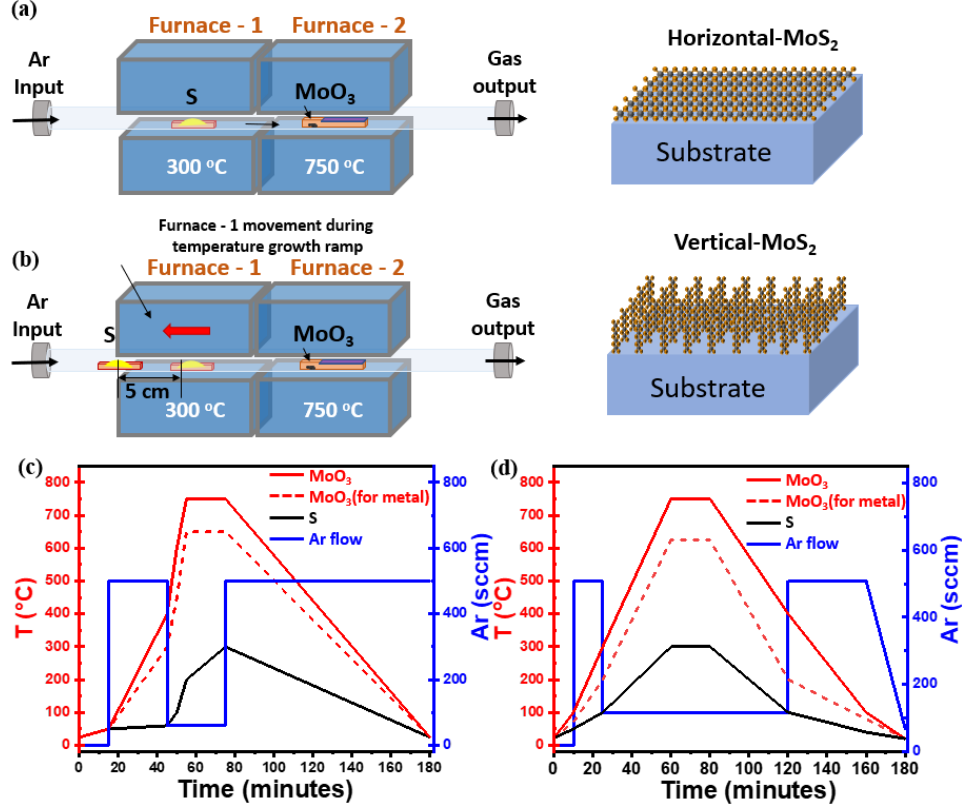
Figure 1. ( a ) Schematic diagram of the horizontal two-zone CVD furnace for the synthesis of flat-MoS 2 . ( b ) Modified CVD setup used to synthesize vertical-MoS 2 nanosheets by adjusting the boat position during the growth temperature ramp on different substrates ( c ) Different steps of temperature profile (left y -axis) adopted for the synthesis of flat-MoS 2 nanosheets with growth ramp at 750 °C (solid line, SiO 2 /Si) and 650 °C (dash line, TaN) for 20 min; in the same graph the Ar flux changes during the CVD process are also plotted (blue solid line, right y -axis). ( d ) Three step temperature profile (left y -axis) used for the synthesis of vertical-MoS 2 nanosheets with growth ramp at 750 °C (solid line, SiO 2 /Si) and 625 °C (dash line, TaN) for 20 min; in the same graph the Ar flux changes during the CVD process are also plotted (blue solid line, right y -axis).